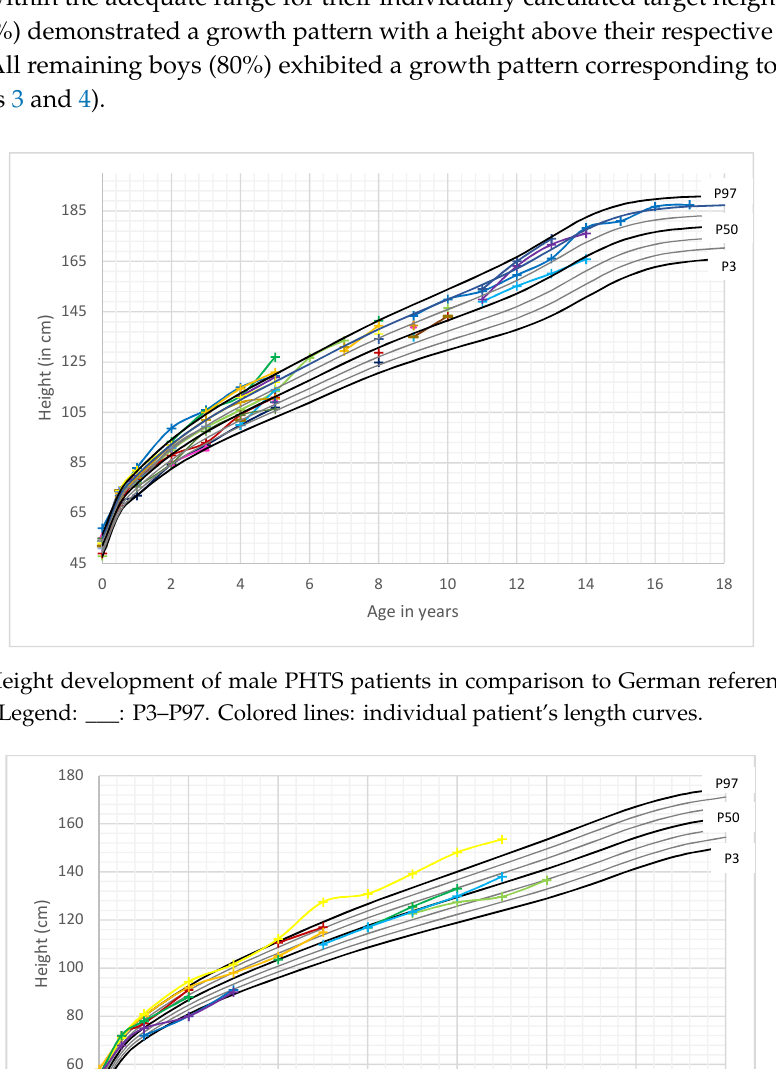
Table 1. Rate of overweight and obesity in pediatric patients with PHTS.